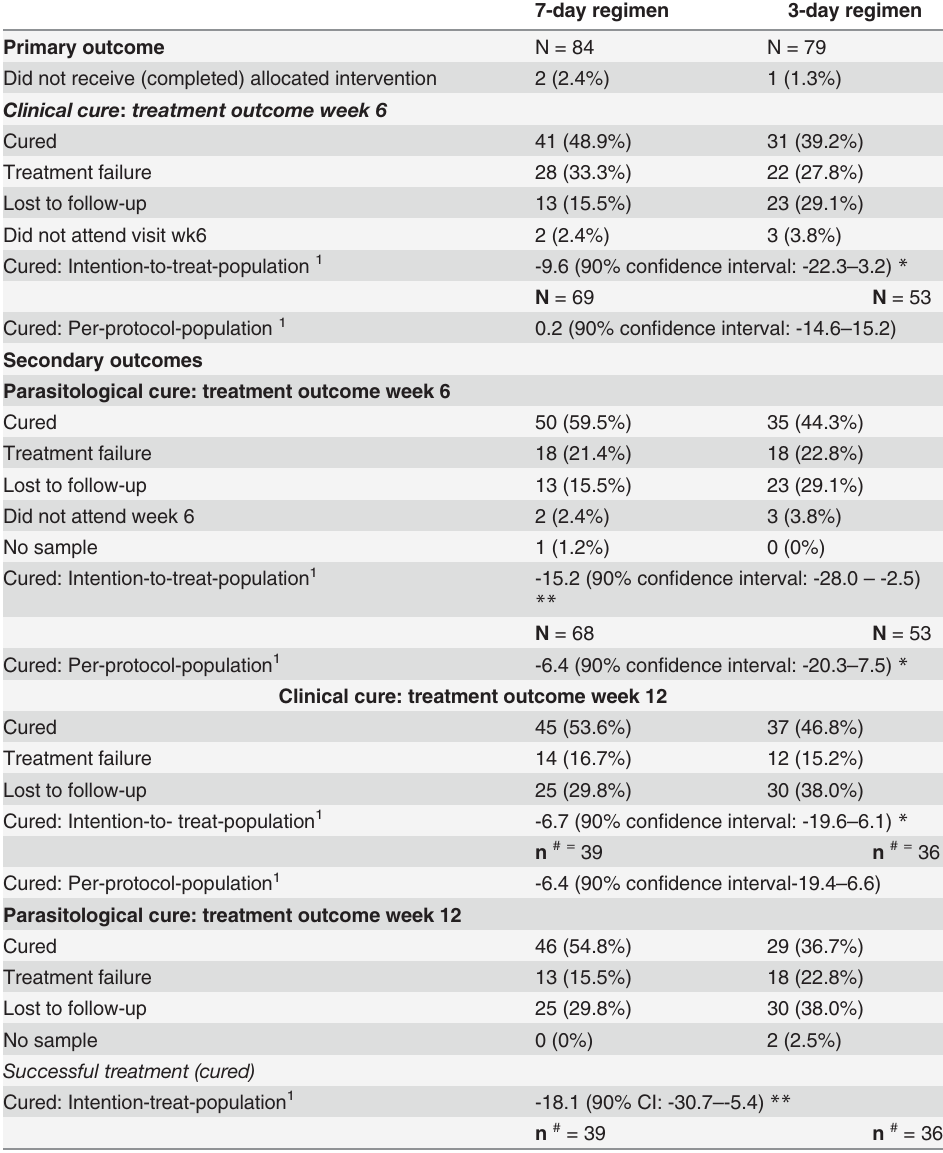
Table 2. Efficacy analyses: Responses to treatment at follow-up 6 weeks and 12 weeks after treatment according to treatment of cutaneous leishmaniasis patients in Suriname from 2010 – 2013. 7-day regimen 3-day